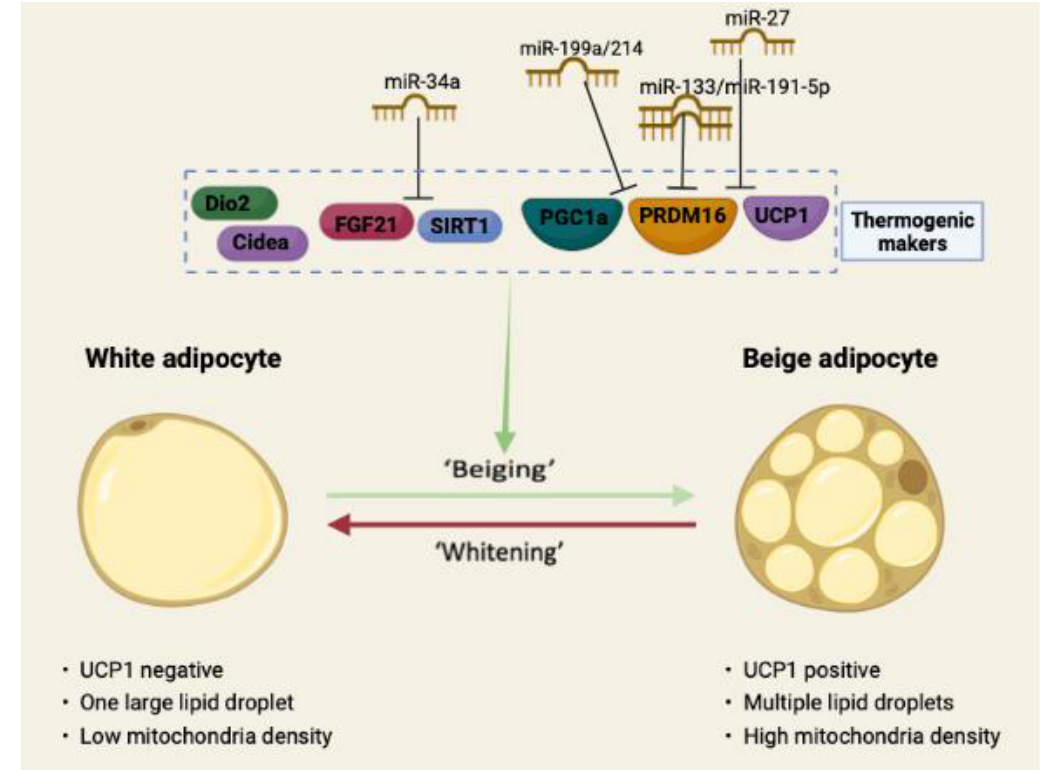
Figure 1. miRNAs inhibited adipocytes browning process. Regulation of the WAT beige process involves the action of a few specific proteins and nucleic acids. This trans-acting factor orchestra regulates genes related to mitochondrial biogenesis, cellular oxidative capacity, and non-shivering thermogenesis. The action of some microRNAs (such as miR-133, miR-34a, miR-27, etc.) inhibits the process of WAT browning.